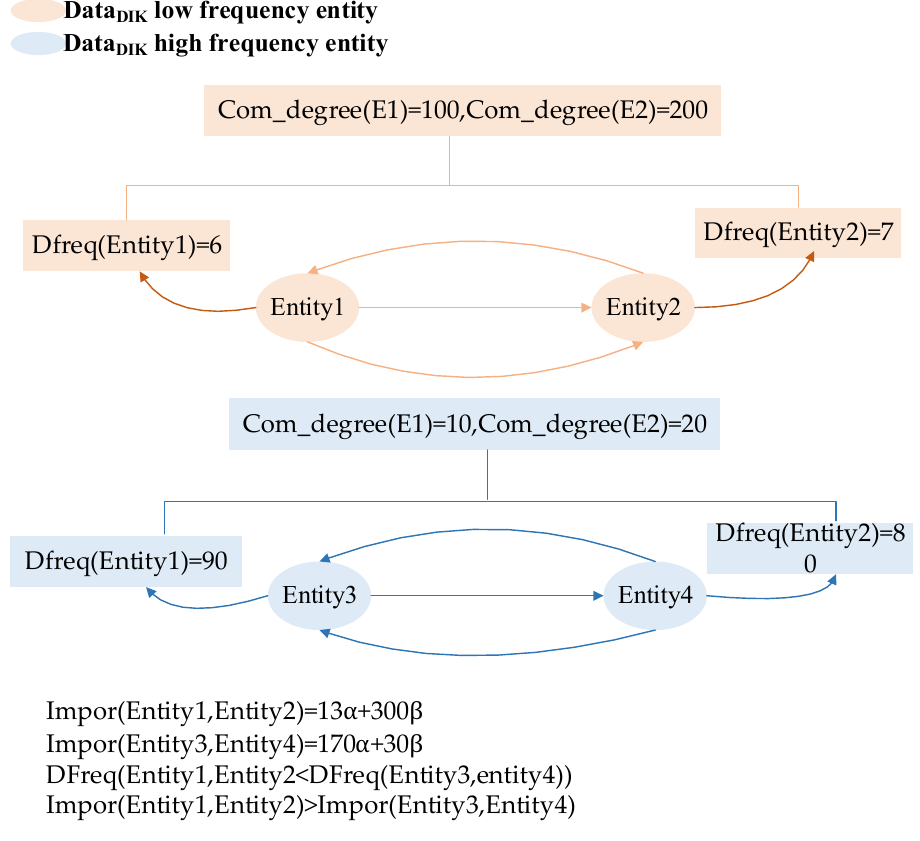
Figure 4. Measuring the importance of entity nodes in Information DIK.